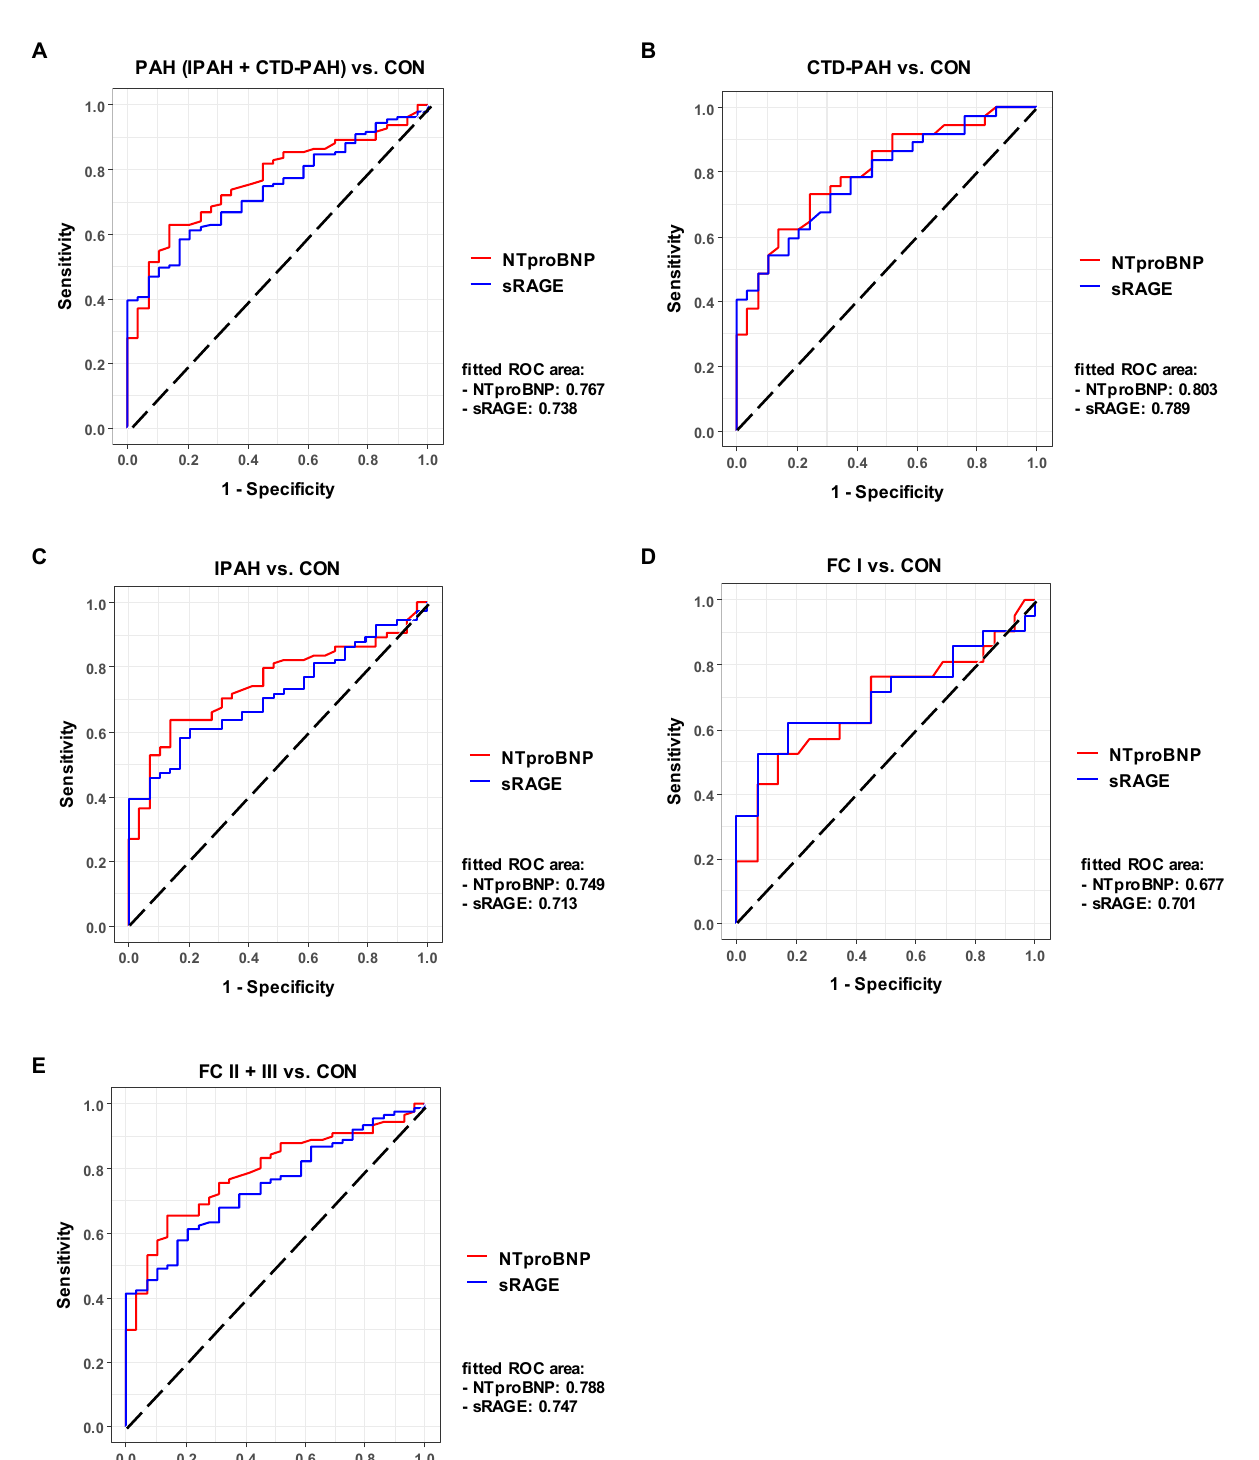
Figure 3. Plasma sRAGE has diagnostic accuracy in adult PAH comparable to the gold standard NTproBNP. Comparisons of various PAH groups vs. control ( A – C ) and functional classes vs. control ( D , E ) illustrate that sRAGE has comparable diagnostic accuracy to NTproBNP and even outperforms NTproBNP in the FC I vs. control comparison ( D ), i.e., AUC sRAGE > AUC NTproBNP . Abbreviations: AUC, area under the ROC curve; NTproBNP, N-terminal pro-brain natriuretic peptide; ROC, receiver operating characteristic; sRAGE, soluble receptor for advanced glycation end products.